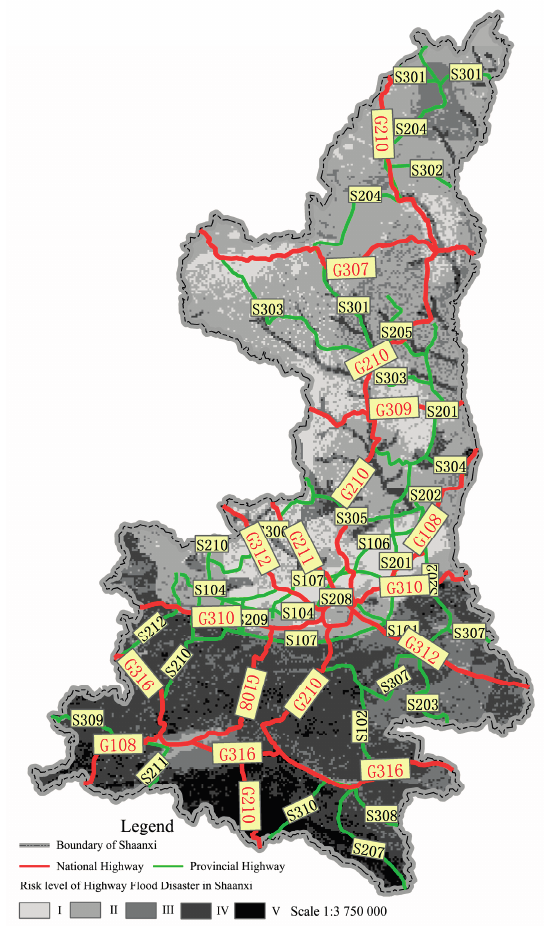
Figure 3. Distribution of trunk-highway flood disaster risks in Shaanxi